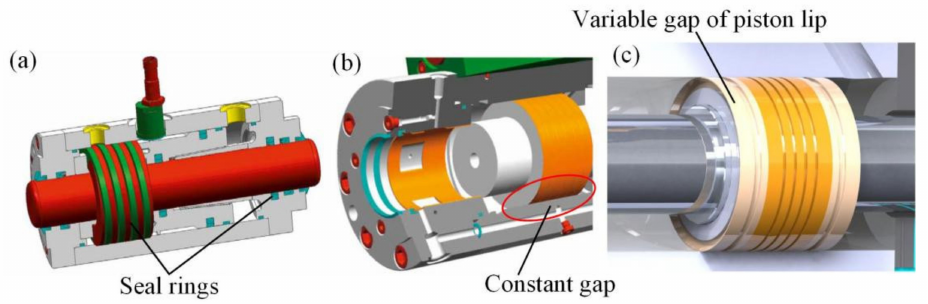
Figure 1. Three sealing forms for hydraulic cylinders: ( a ) the sealing ring; ( b ) the constant gap seal; ( c ) the variable gap seal.